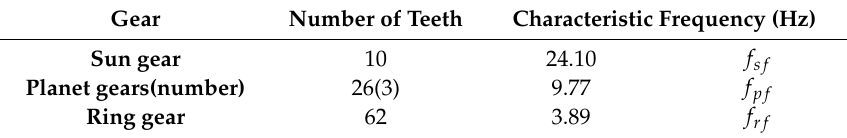
Figure 4. The fault modes: ( a ) sun gear chipped; ( b ) planetary gear bearing with inner-race fault. Table 1. Structural parameters and kinematical parameters of the planetary gearbox.